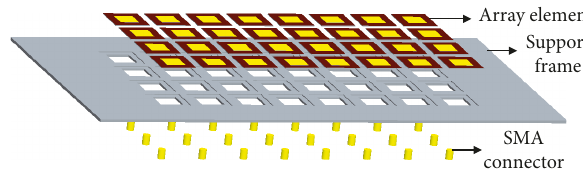
Figure 6: Structure of the antenna